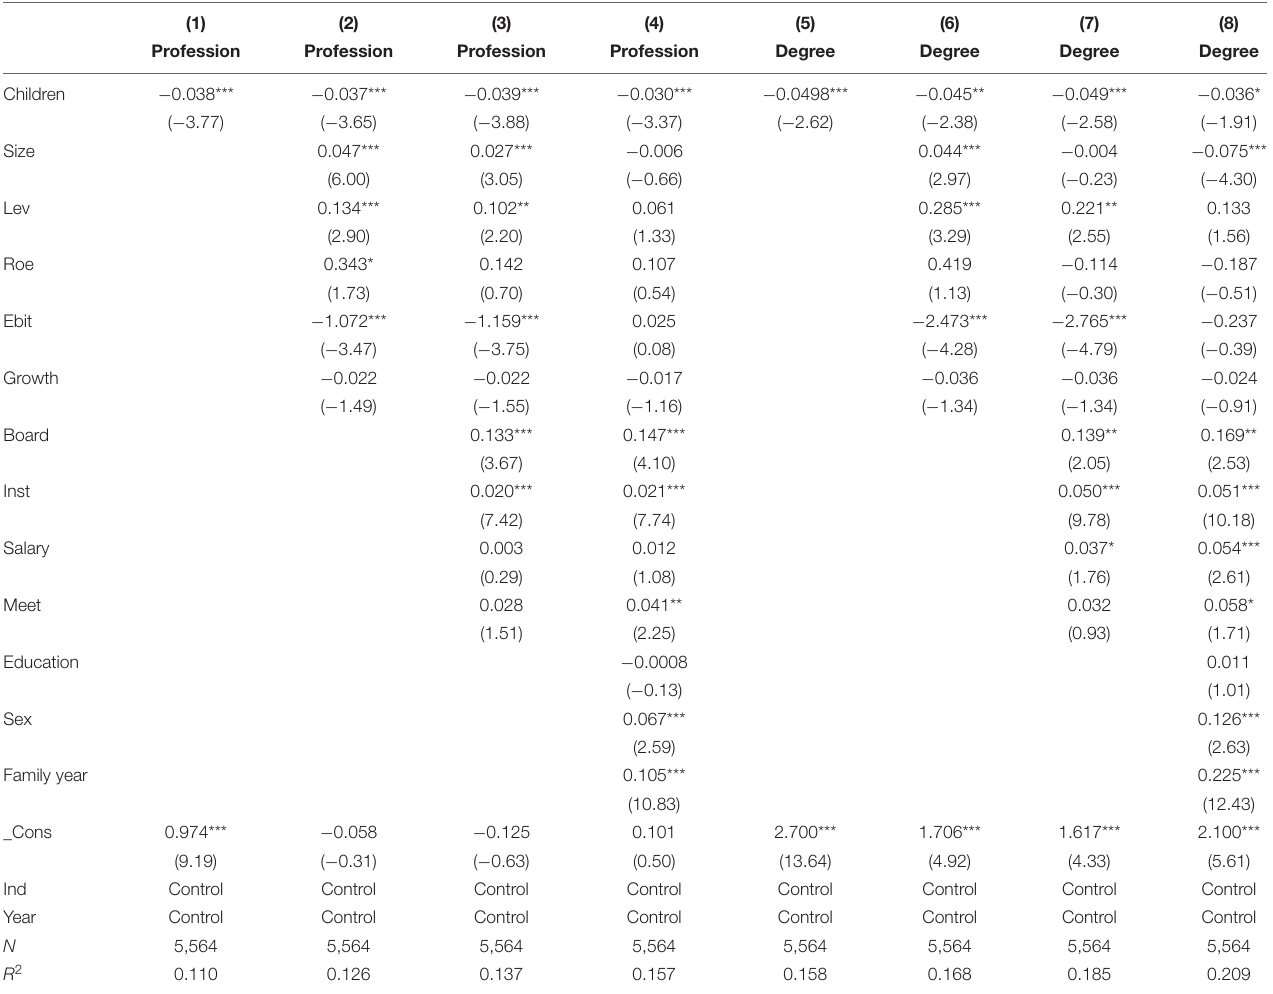
TABLE 8 | Replacement of the control variables: the number of children of actual controllers and professional